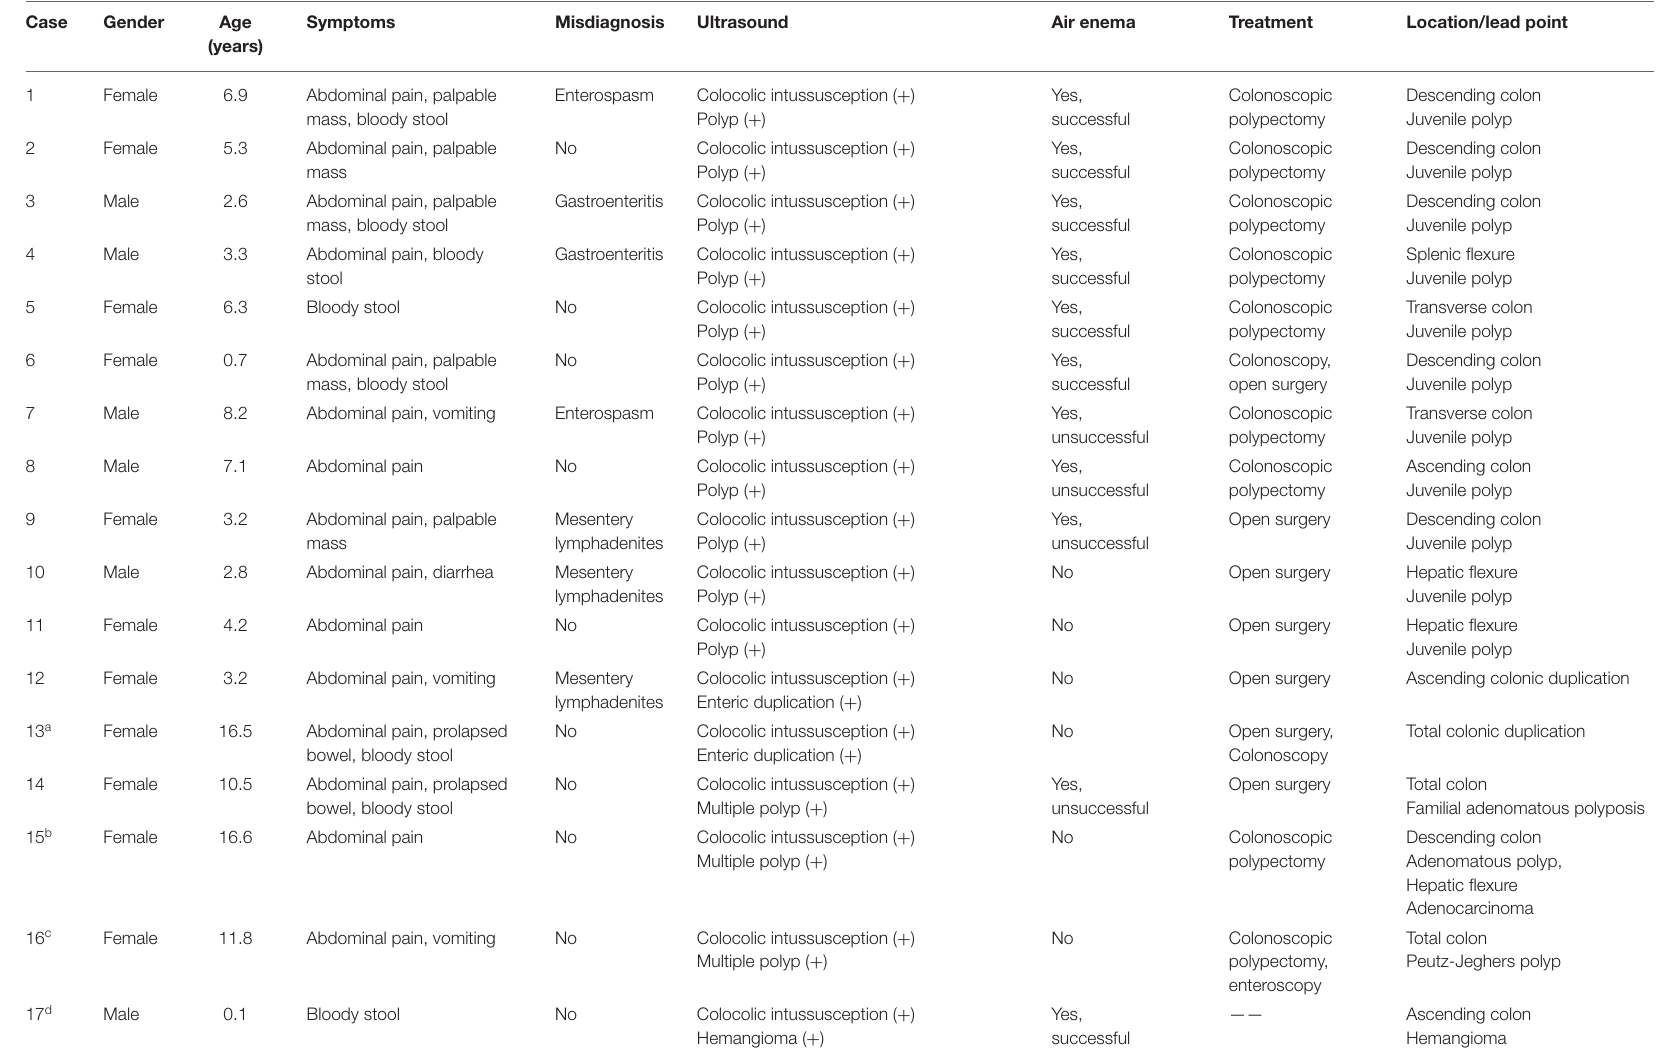
TABLE 2 | Clinical features of 17 patients with colocolic intussusception at our center between 2010 and